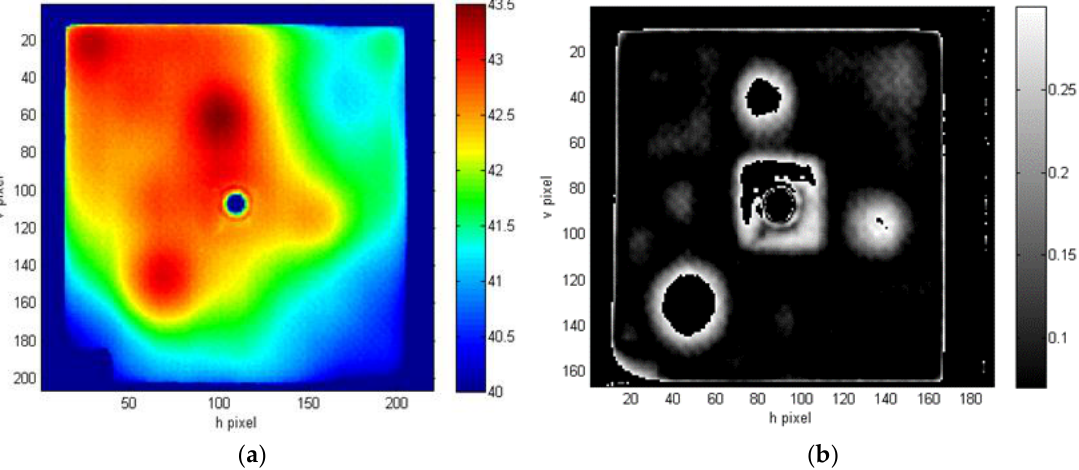
Figure 14. Comparison between raw thermal map ( a ) and ( b ) contrast Image of CFRP Plate I on Side A obtained after 39.4 cooling seconds after heating pulse of 30 s.